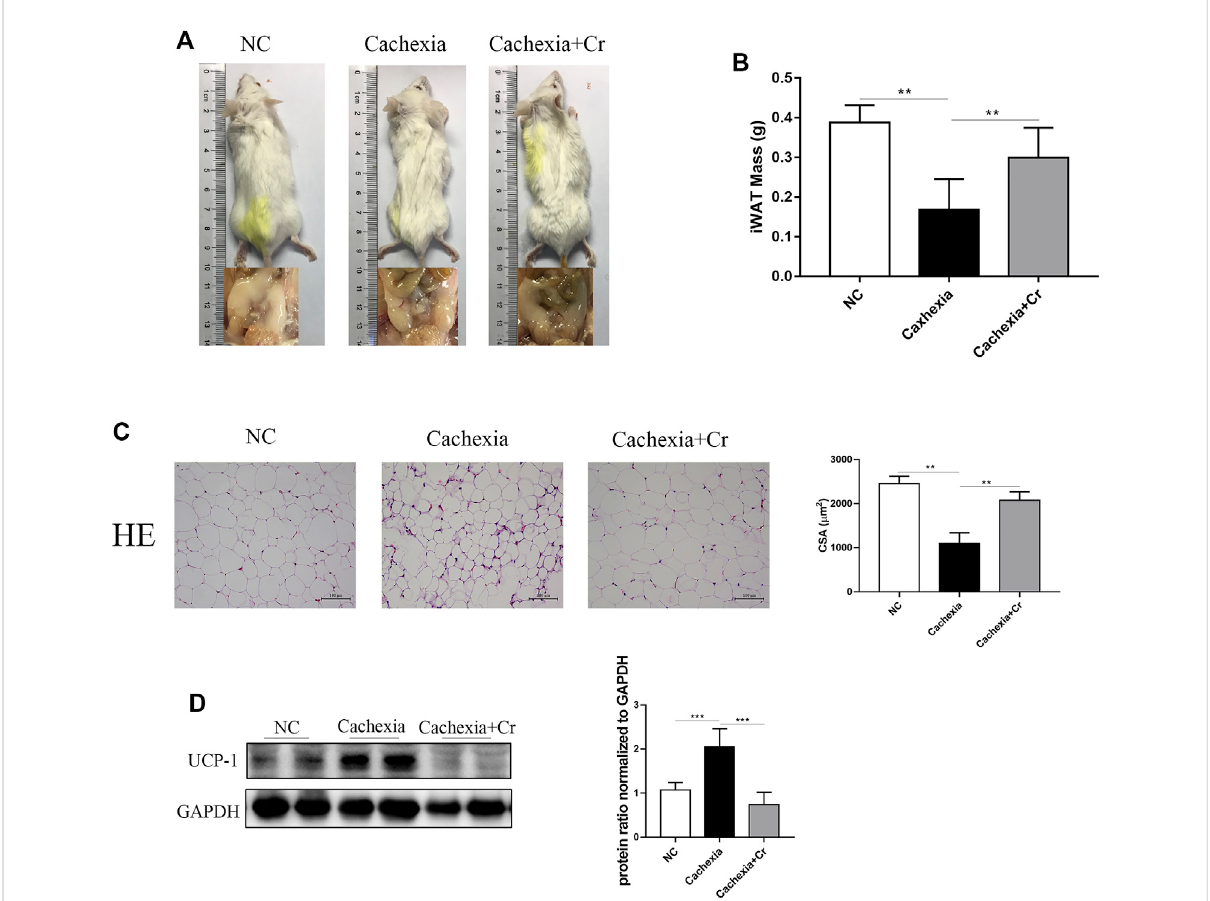
FIGURE 3 Creatine prevents the browning of white adipose tissue, thereby protecting against adipose tissue wasting. (A) Representative general images andhomologousgroinimagesofthethreegroups.NCgroup:normalcontrolmice,cachexiagroup:C26tumor-bearingmice, cachexia+Crgroup: Creatine-treated C26 tumor-bearing mice. (B) iWAT mass changes in the three groups (mean ± SD, n = 6). ** p < 0.01 denoted the NC group versus the cachexia group, ** p < 0.01 denoted the cachexia group versus the cachexia + Cr group. (C) Representative HE staining showing the morphologicalchangesintheadiposetissueofthethreegroups.Averagesizeofadiposetissuecross-sectionalareainthethreegroups. (D) Western blotanalysiswasusedtoevaluateUCP-1expressioninthethreegroups(mean±SD, n =6).* p < 0.05,** p < 0.01,*** p < 0.001.Dataareexpressedas the mean ±